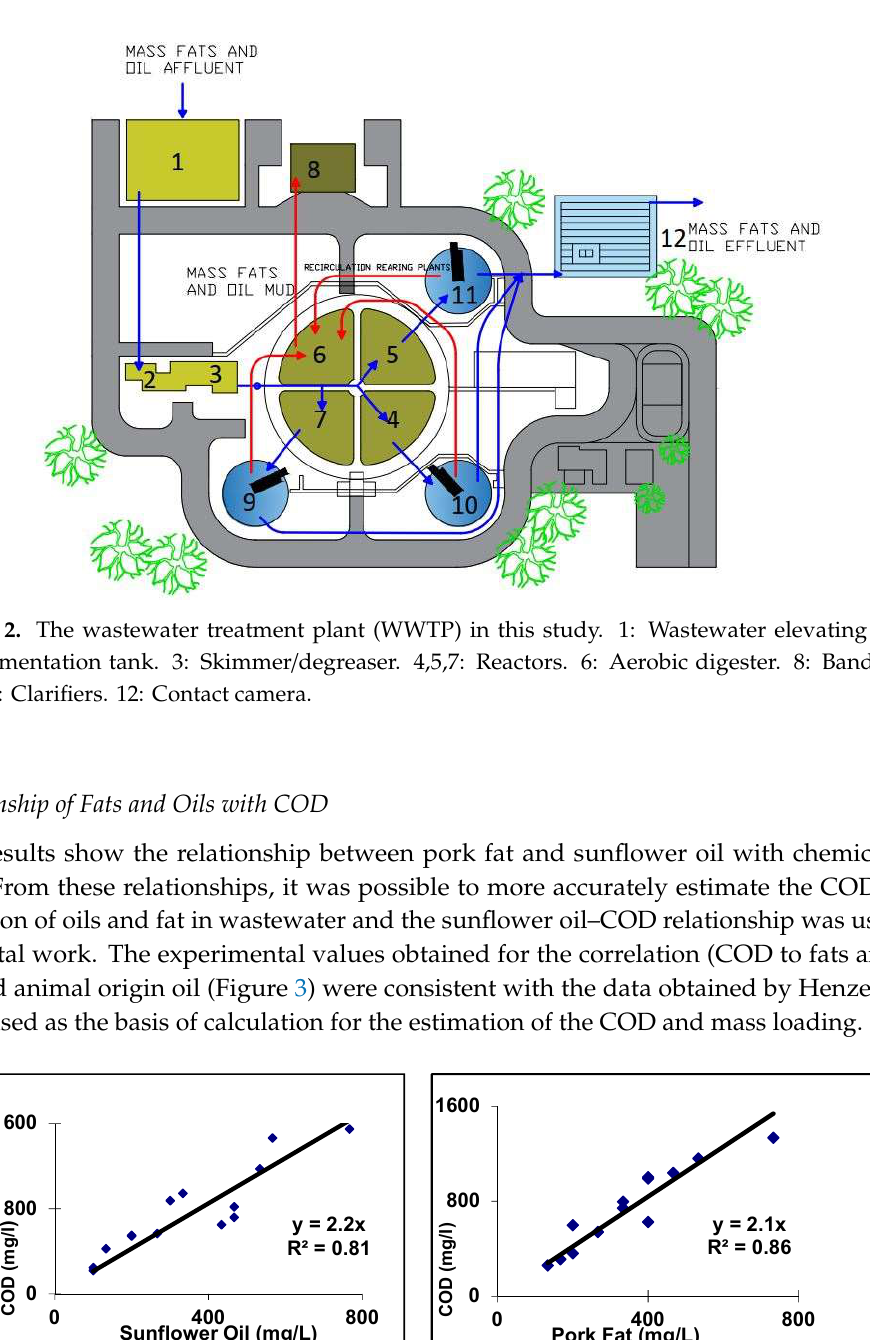
Figure 3. Relationship of ( a ) COD and sunflower oil and ( b ) COD and pork fat.